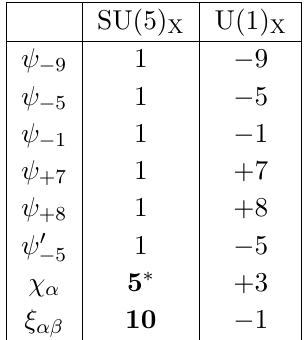
Table 1 . Quantum numbers of the particle contents of the model. The shown are the particle contents for energy scales greater than SU(5) X confinement scale ( Λ X ). Below the Λ X , two χ α and a single ξ αβ form the bound state Ω X in eq.